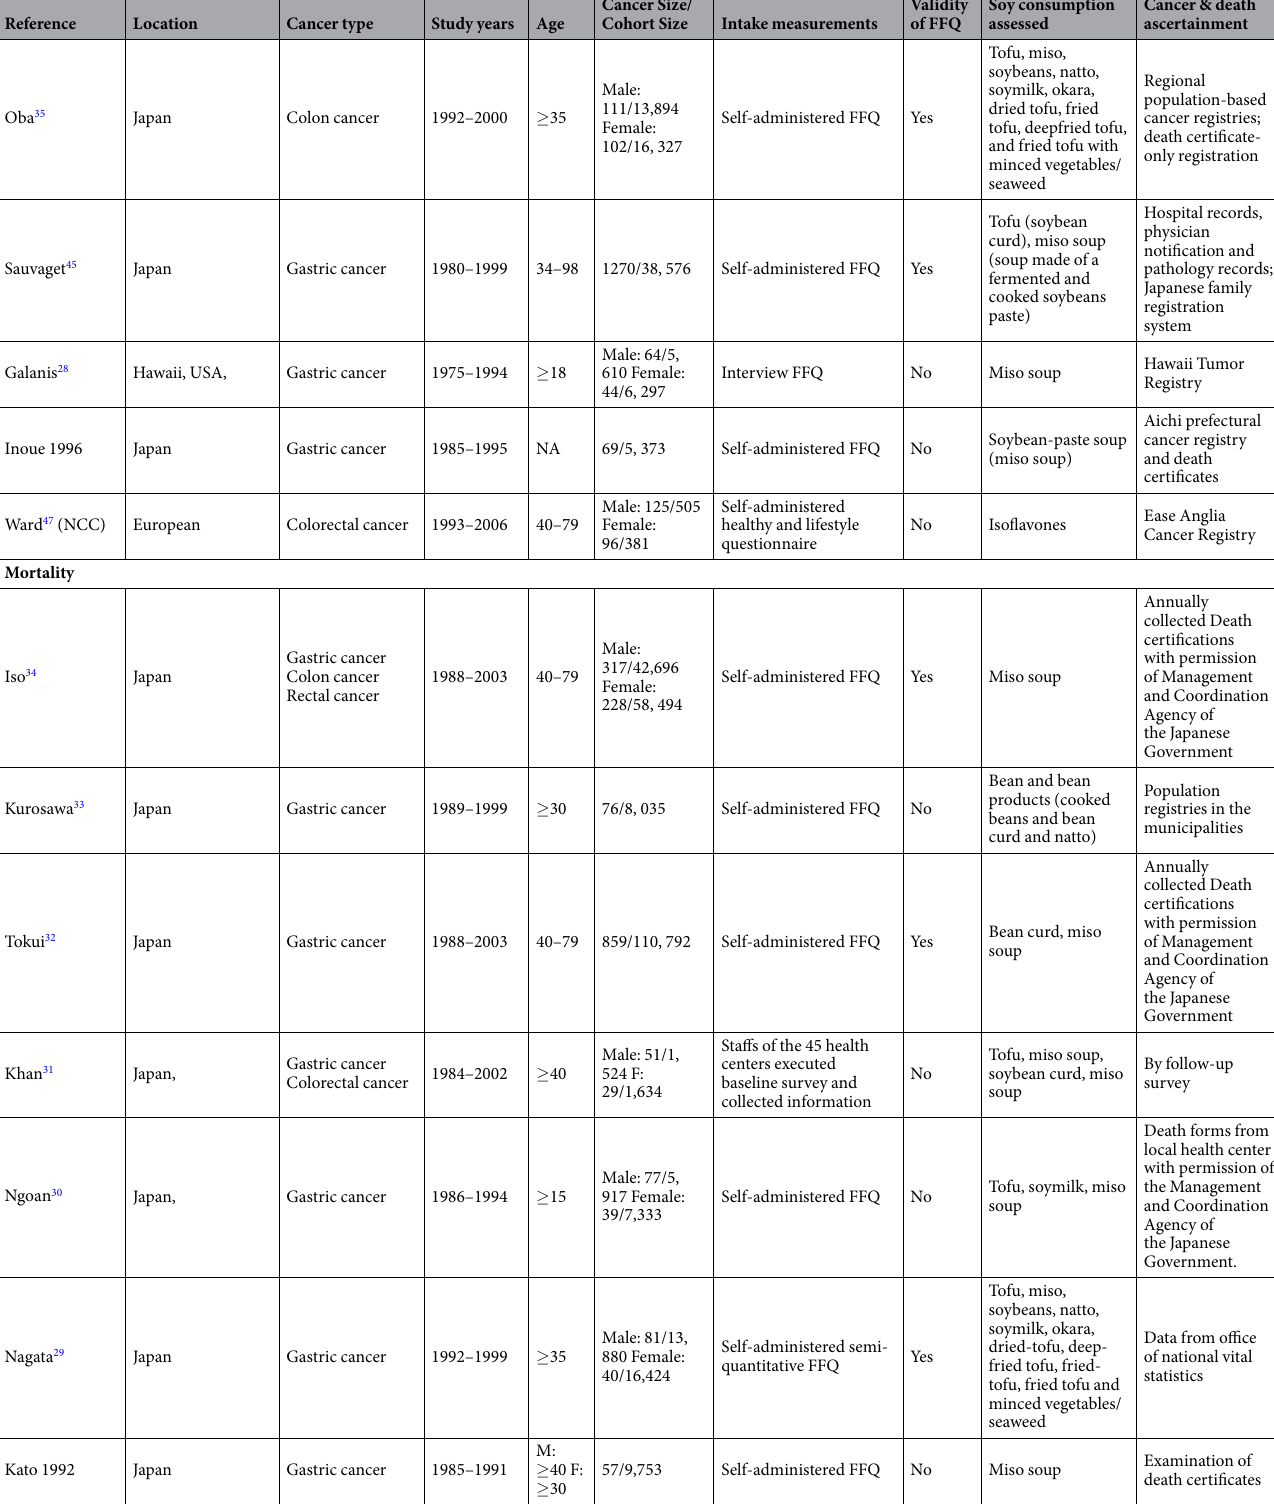
Table 1. Study features of soy consumption and gastrointestinal cancer risk. FFQ: Food Frequency Questionnaire; NA: Not